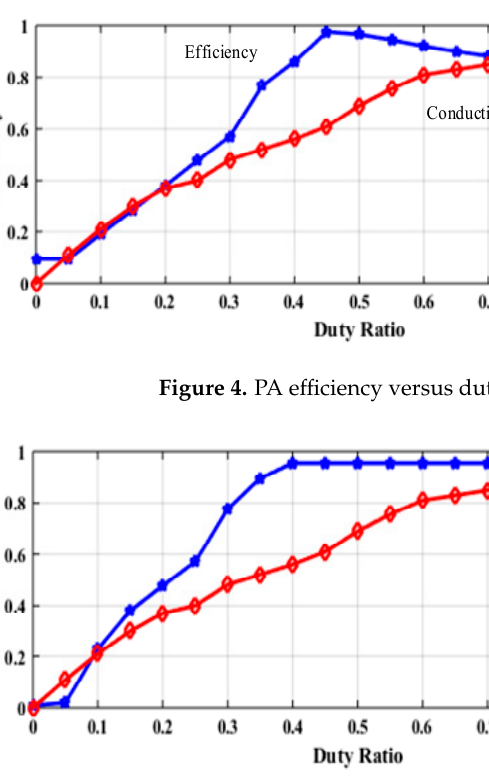
Figure 5. PA normalized voltage, angle versus duty ratio.